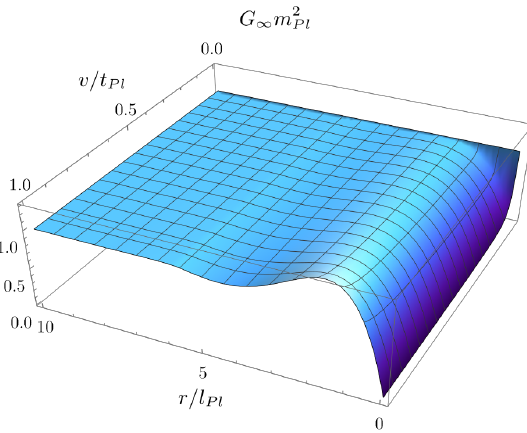
Figure 3 . Numerical solution to the partial differential equation (3.27) for the effective Newton coupling G . We use as initial condition at early times and boundary condition in the IR the ∞ observed value of the Newton constant, i.e. G ( r, v ) = G ( r ) = G . For the remaining ∞ 0 ∞ max , v 0 boundary condition near the origin at r we use the result (4.12) associated with the dynamics in min the proximity of the would-be singularity. At early times for all r , as well as at large distances for all v , the effective Newton coupling reproduces the observed value of Newton’s constant, G . When 0 the collapse process starts, the effective Newton coupling decays as ' v − 1 until the shell-focusing is over. At the end of the collapse, the effective Newton coupling converges to a function which interpolates between G (large-distance limit) and zero (for small radii). This function features in 0 addition damped oscillations along the radial